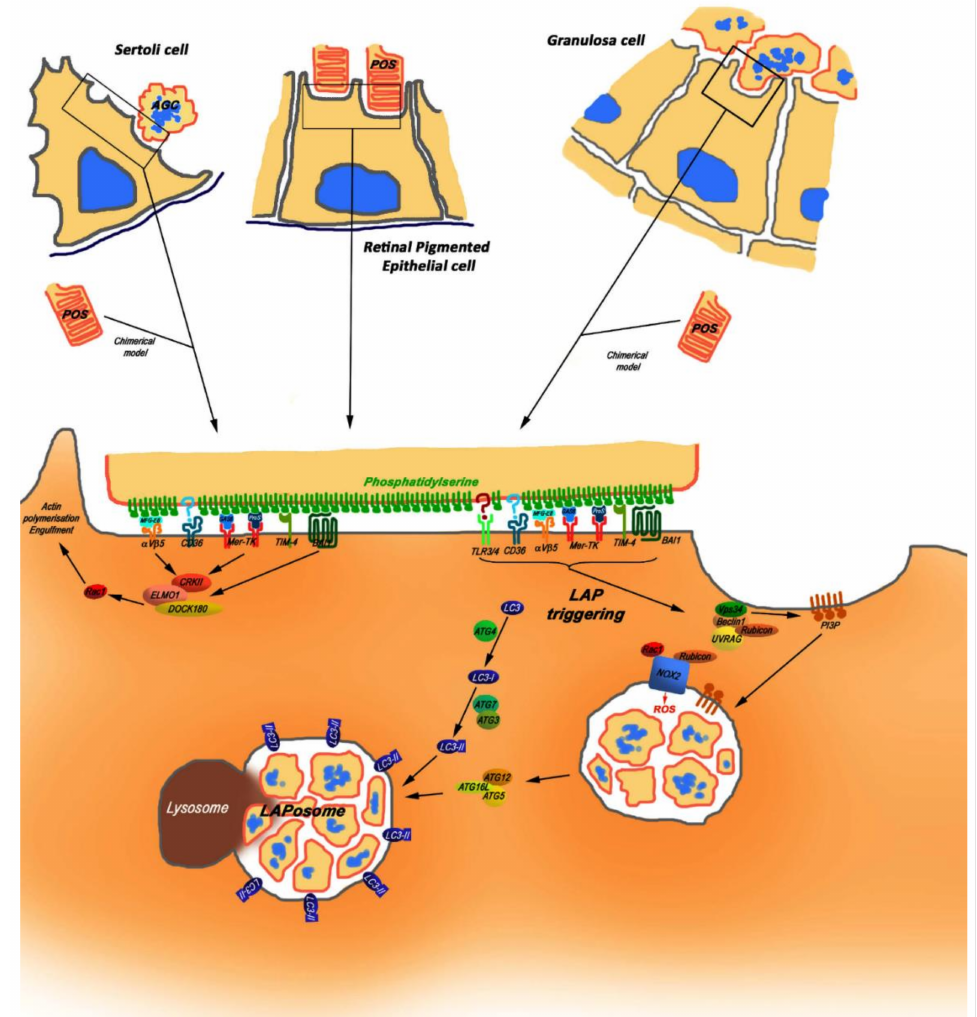
Figure 3. Elimination of apoptotic substrates in blood-separated retina, testis and ovaries. In each organ, specific non-professional phagocyte cells are in charge of the elimination of apoptotic substrates: Sertoli cells for germ cells in the testis, retinal pigmented epithelium cells for POS in the retina, and granulosa cells for apoptotic oocytes in ovarian follicles. In each case, and even for granulosa cells or Sertoli cells challenged with chimerical substrates (POS), LAP is triggered through the activation of different receptors recognizing specific molecules on the surface of apoptotic substrates. Among those receptors, MERTK plays a central role, allowing both the triggering of actin reorganization through Rho-GTPases, leading to engulfment of substrates, and assembling complexes of proteins accomplishing LAP. Abbreviations: LAP—LC3-associated phagocytosis; POS— photoreceptor outer segments, RB –spermatid’s residual bodies; AO—Apoptotic Oocyte; AGC— Apoptotic Germ